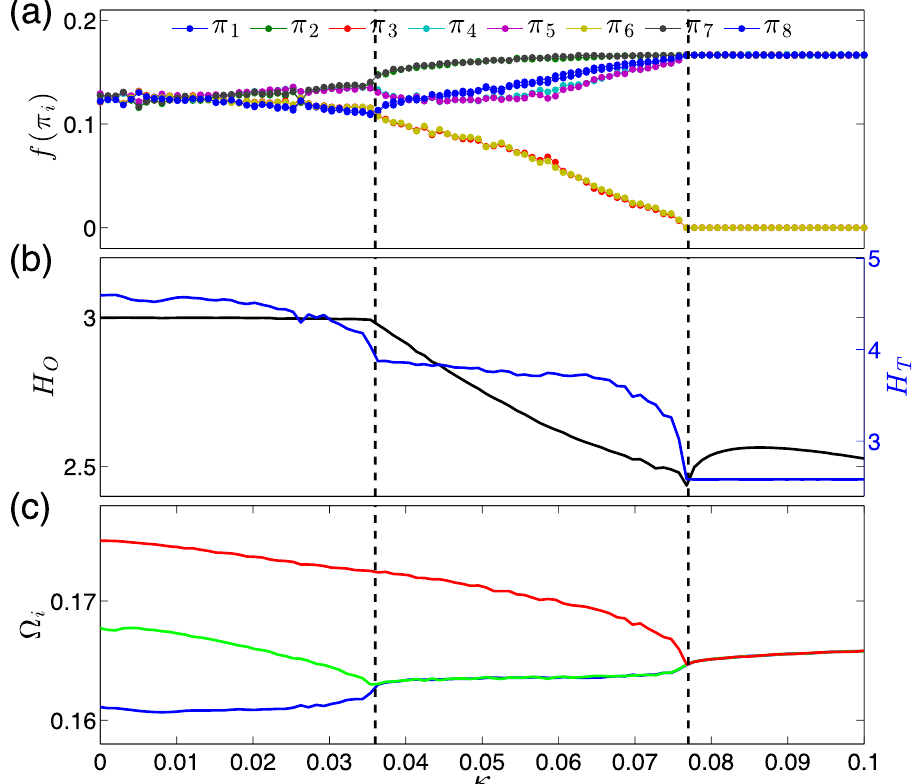
Figure 8. Phase synchronization transitions of three coupled Rössler systems. ( a ) Frequency of each ordinal  , ( c ) mean rotation frequency Ω i of each oscillator. Subsystem k 1 and pattern f ( π i ), ( b ) entropy values  and O T k 2 are synchronized at κ c 1 = 0.036, and k 3 joins the synchronization only at a stronger coupling strength = 0.077. Both critical coupling values are highlighted by vertical dashed κ c 2